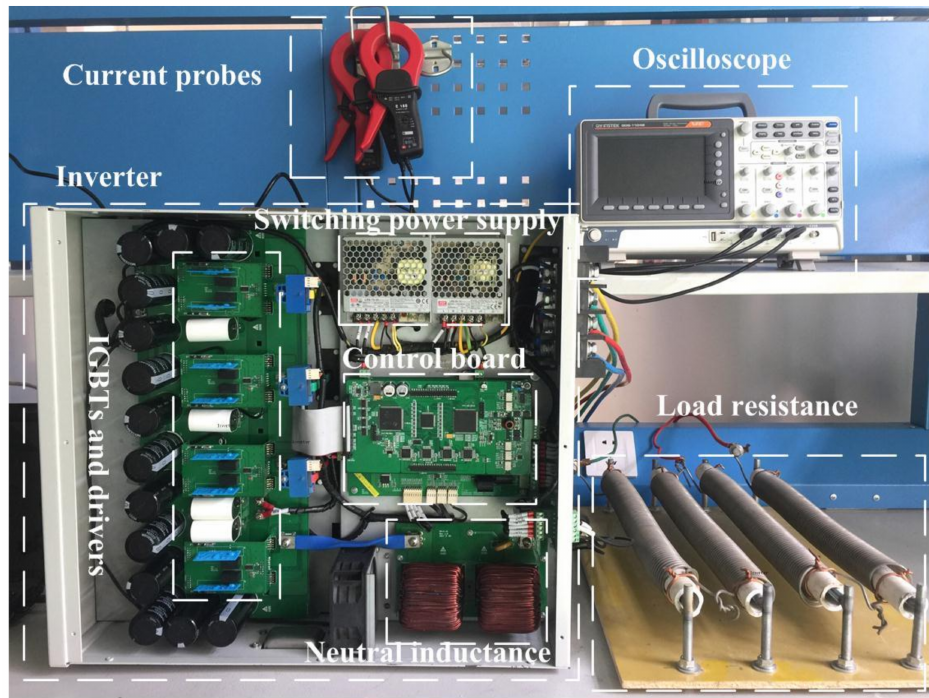
Figure 20. Photograph of the experimental test